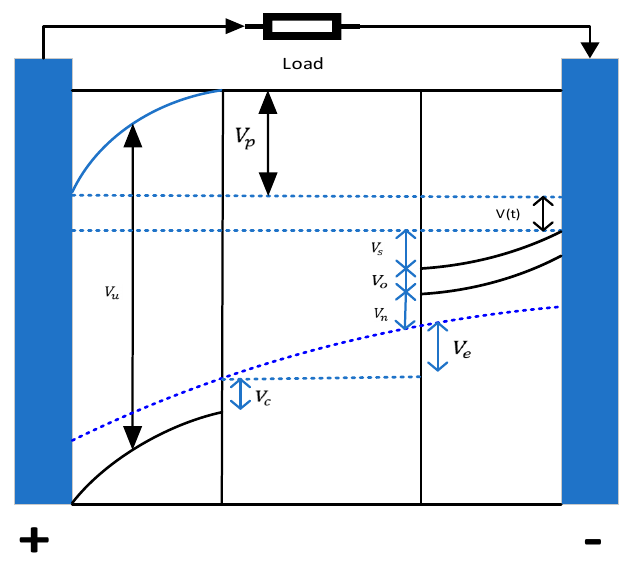
Figure 4. Physical model of a lithium battery.